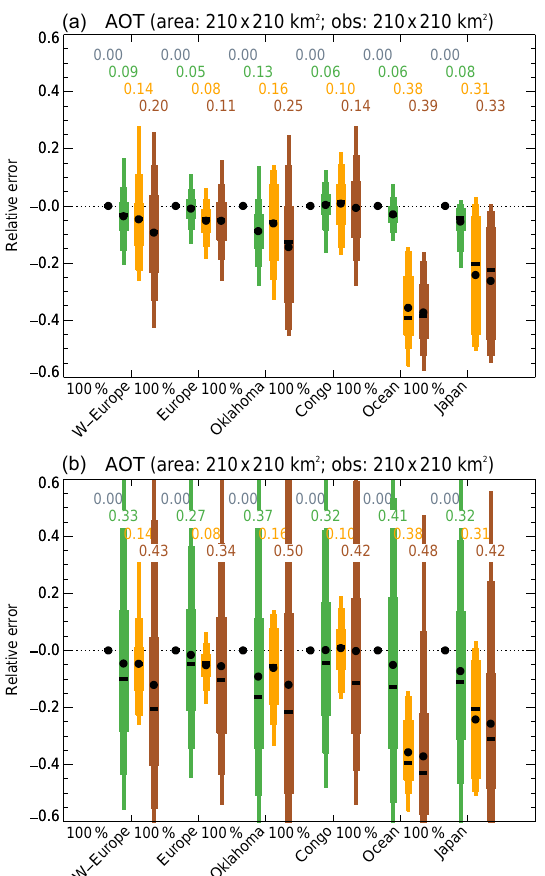
Figure 12. Monthly representation errors for an imager on a polar- orbiting satellite after collocation: purely spatial sampling (grey; zero by construction), no collocation (brown), model data collo- cated to the day of observations (bright orange) and finally model data collocated to the hour (red). The grey and brown error esti- mates are similar to Fig. 11, except for a required coverage of 25%. Panel (a) is for an imager with a repeat cycle of 1 day, (b) for a repeat cycle of 8 days. Further explanation in Sect.